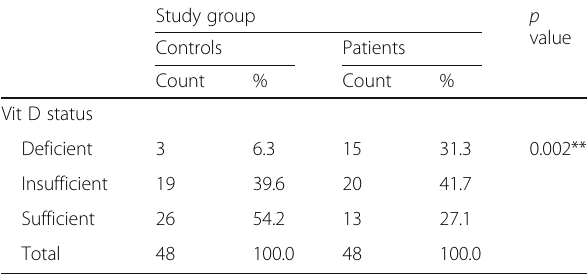
Table 2 Comparison of mean serum vitamin D level between study subgroups